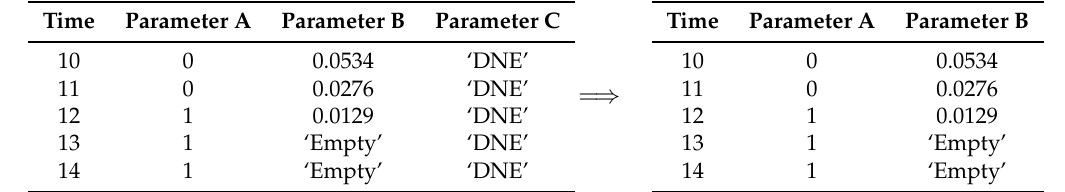
Table 1. Notional process for FOQA data deletion.